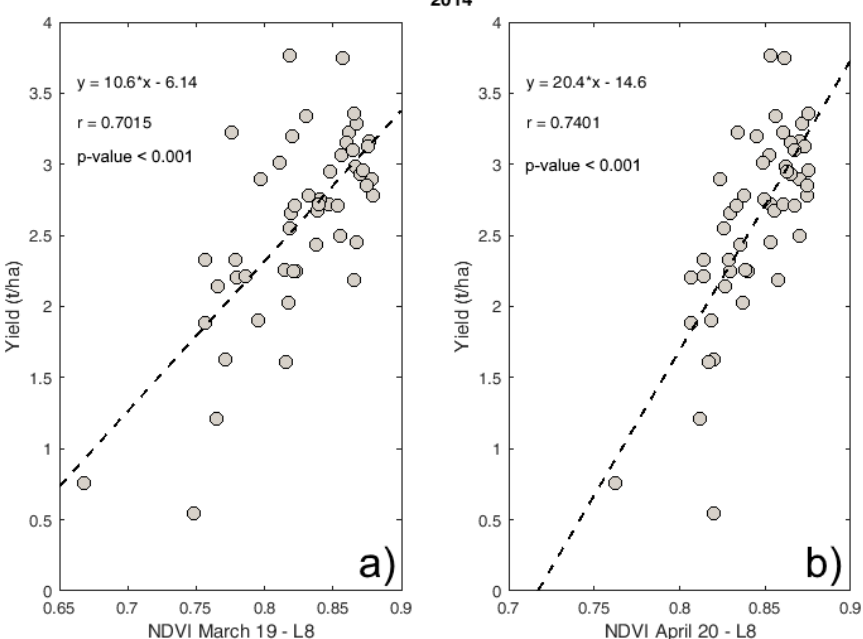
Figure 4. Relationship between observed yield (yield monitor) and NDVI (Landsat-8) for 2013–2014 crop season in ( a ) 19 March and ( b ) 20 April.